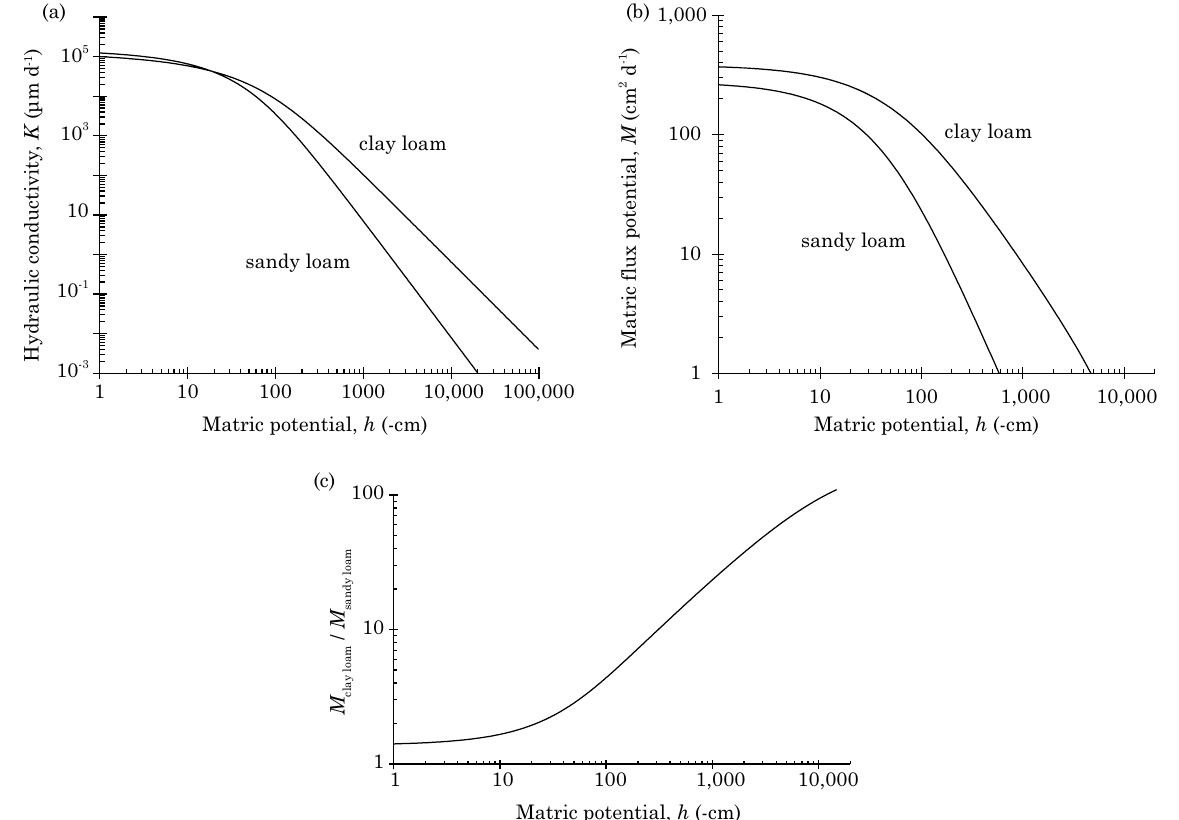
Figure 4. Hydraulic conductivity K (a), the matric flux potential M (b) (integral as calculated by equation 7, with h l = -15,000 cm) as a function of the matric potential for two different soil textures and the ratio of the M values of both soils (c) as a function of the matric